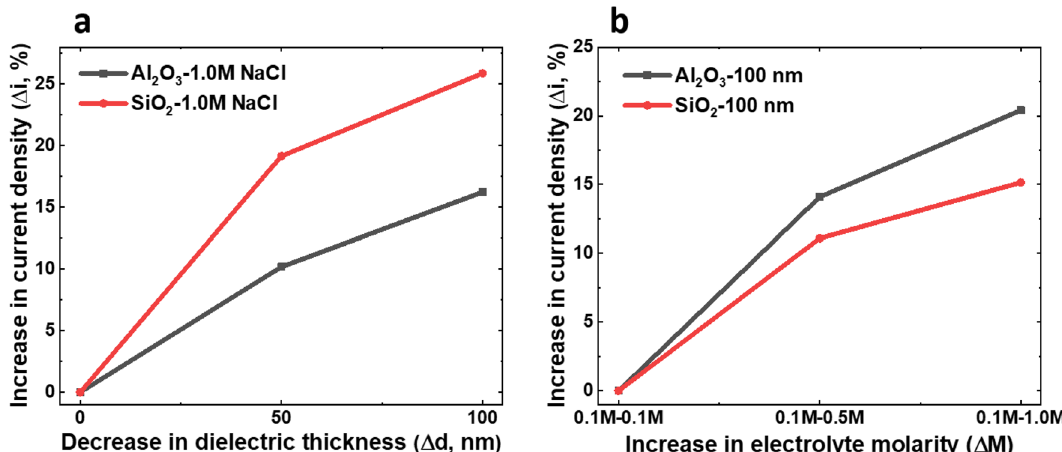
Figure 8. Representative changes (percent increase in current density) with ( a ) decrease in dielectric film thickness (nm) for